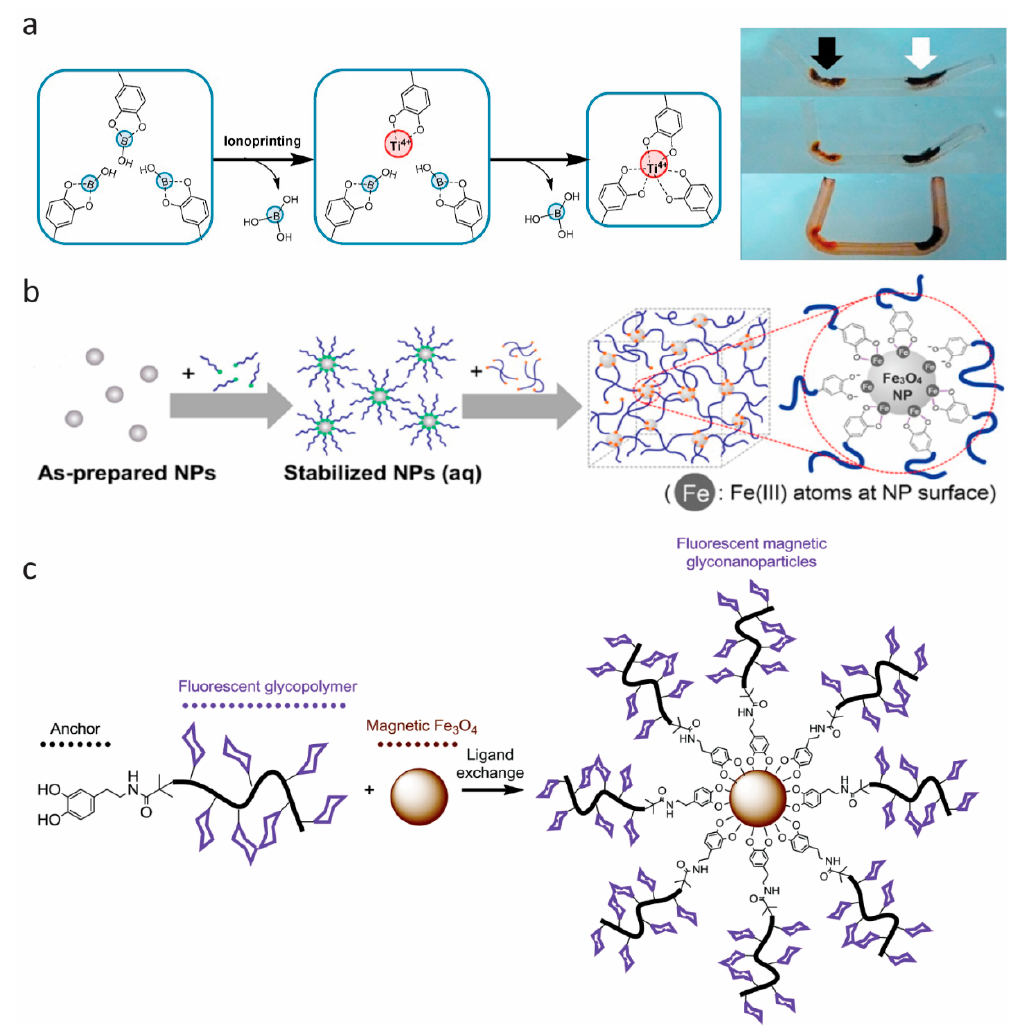
Figure 6. Multifunctional materials. ( a ) Schematic representation of the interaction of –Ti(IV)–catechol in the ionoprinted region, and time lapse photographs showing the actuation of the ionoprinted hydrogel. From top to bottom: The actuation of a hydrogel ionoprinted with titanium (15 V, black arrow) and iron (5 V, white arrow) electrodes, after incubation in pH 9.5, 0.1 M NaCl for 4 min, and after incubation in ethanol for 30 min. Reprinted from [74], Copyright 2016, with permission from Elsevier. ( b ) Schematic illustration of Fe 3 O 4 nanoparticle (NP) cross-linked hydrogel, with stabilized Fe 3 O 4 nanoparticles incorporated into 4-arm catechol-terminated poly(ethylene glycol). Reprinted (adapted) with permission from [75]. Copyright 2016 American Chemical Society ( c ) Schematic illustration of magnetic Fe 3 O 4 nanoparticle with dopamine-terminal fluorescent glycopolymers. Reproduced from [76] with permission of The Royal Society of Chemistry.